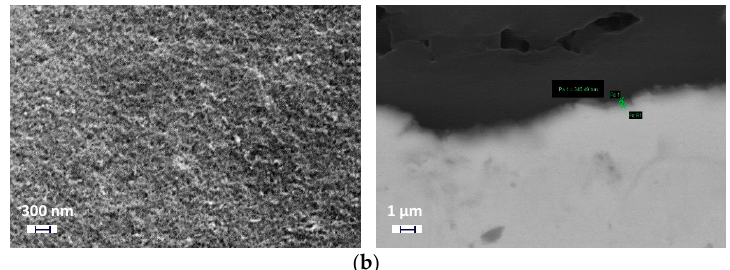
Figure 2. ( a ) Schematic illustration of the synthesis of the sol gels and preparation of the coated films, ( b ) SEM images of structure and thickness of the TSF 32 G thin film.